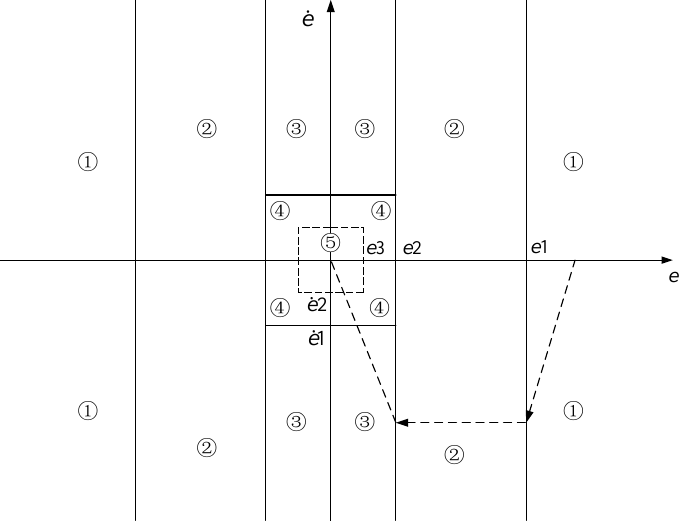
Figure 5. Steering system (angle and torque) phase plane design.